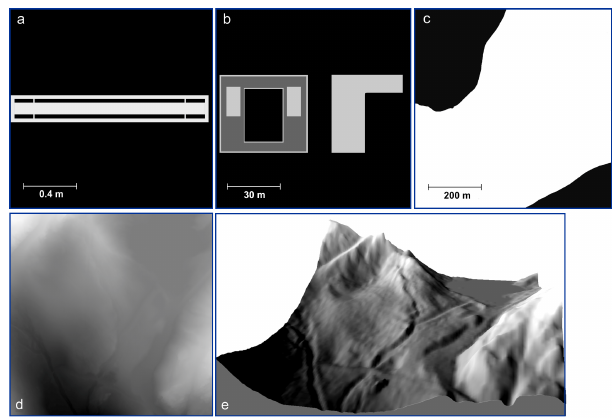
Figure 4. Examples of layers for voxel geometry definitions (all in top view) with grayscale values defining preconfigured mate- rials: gcm − 3 a 2in. proportional counter with 1in. of moderator, (b) the rooftop of the institute of physics in Heidelberg, (c) a part of a lake (Schrön, 2017), (d) voxel geometry for a digital environ- mental model (Kaunertal Glacier at 46 ◦ 52 . 2 (cid:48) N, 10 ◦ 42 . 6 (cid:48) E) with 500 × 500 pixels at a lateral resolution of 1m and 0.5m in height, and (e) shaded illustration of the resulting layered voxel structure from (d)